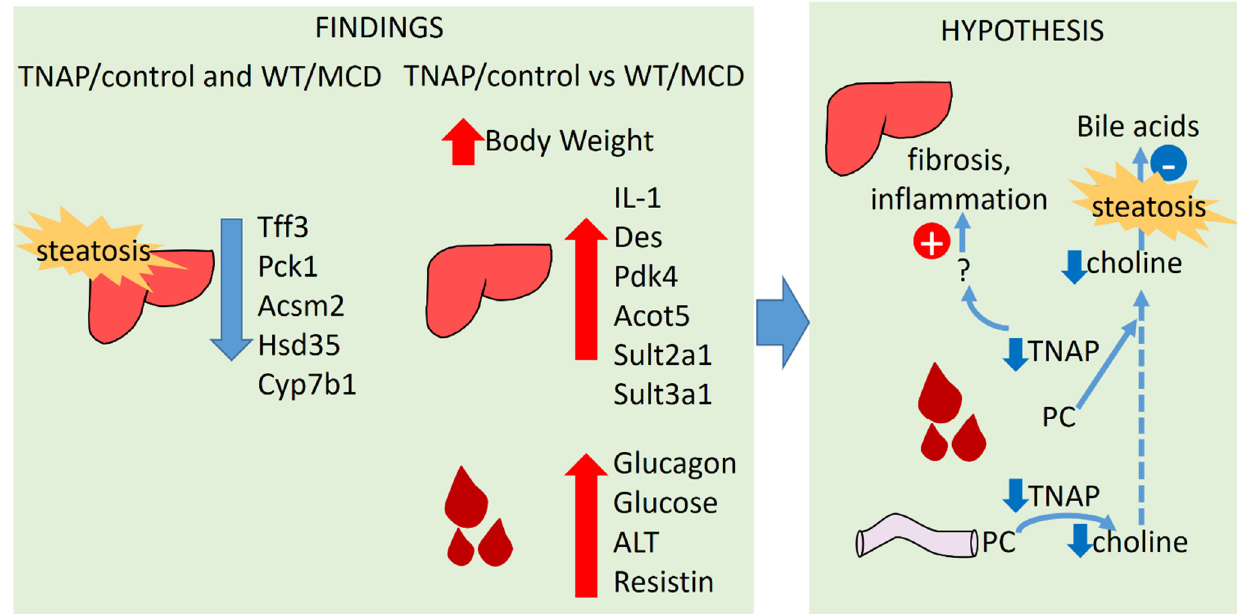
Figure 8. Hypothesis based on the findings of the study.